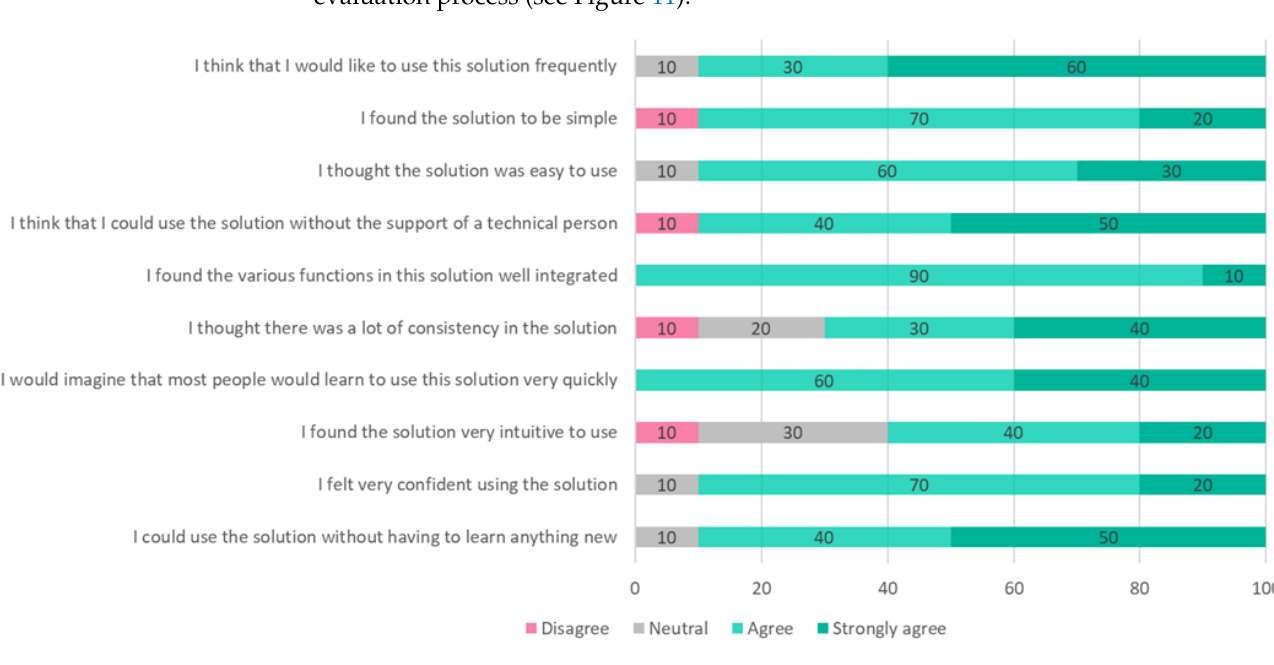
Figure 11. Questions in the human factor questionnaire and answers.